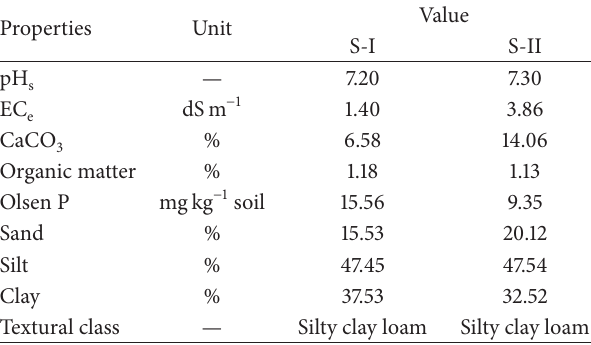
Table 1: Physiochemical properties of the soils used in adsorption